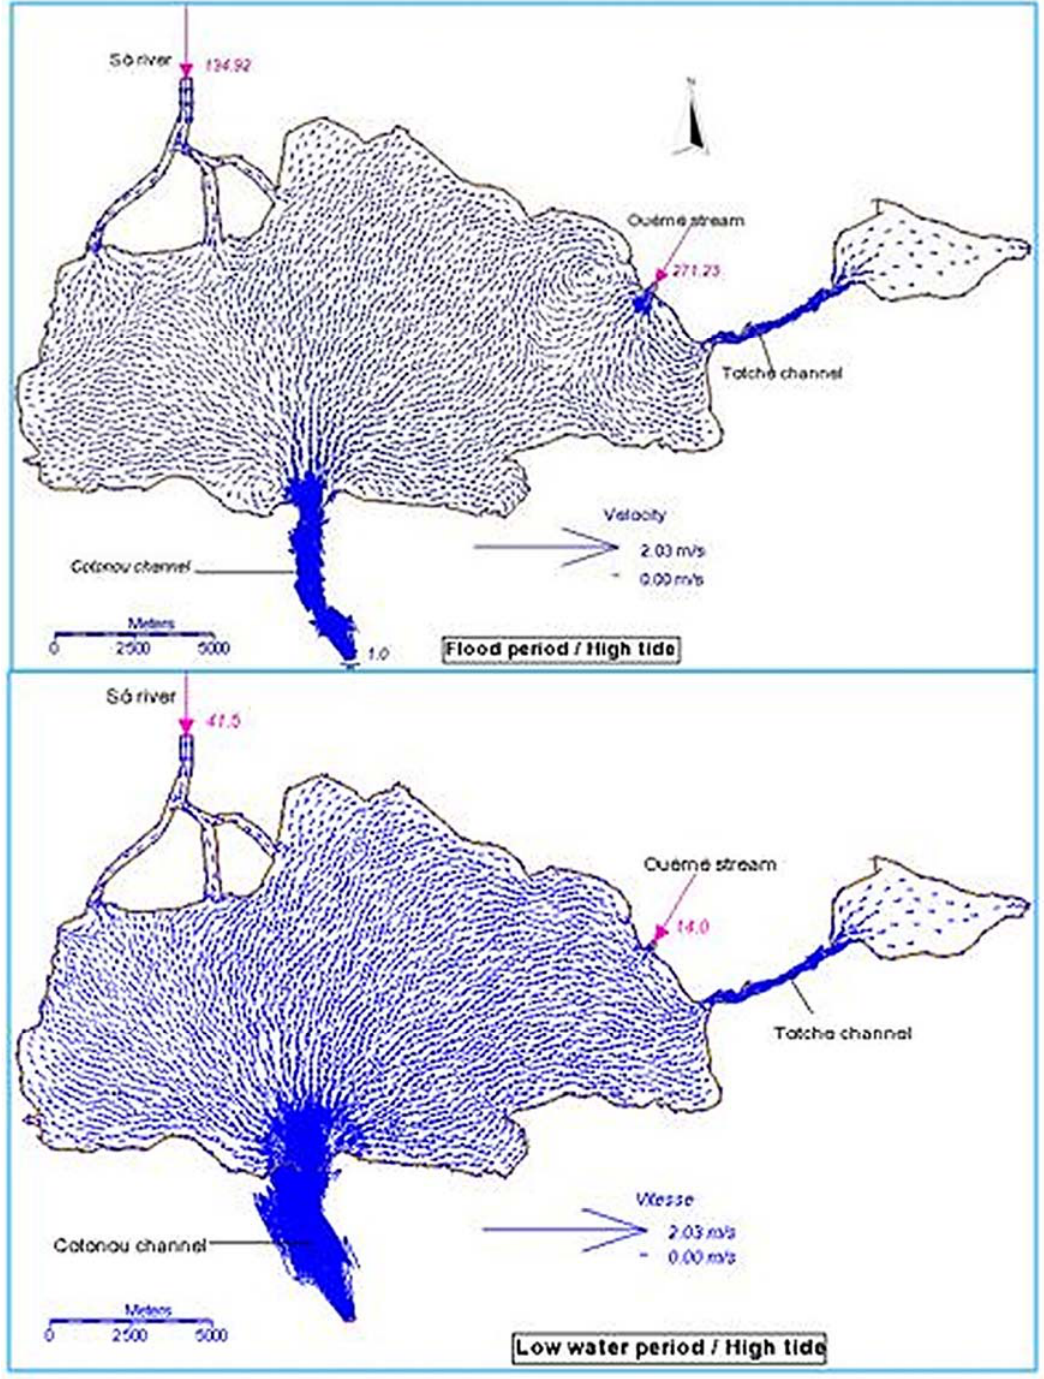
Figure 10. Velocity field distribution during the filling of the lake in flood and low water period.